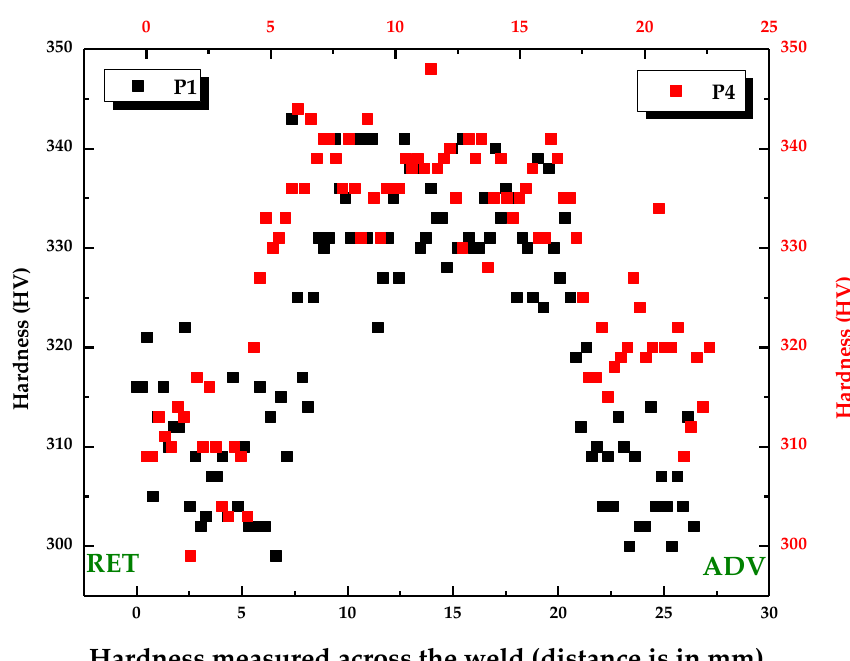
Figure 9. Hardness profile in the center of the weld.